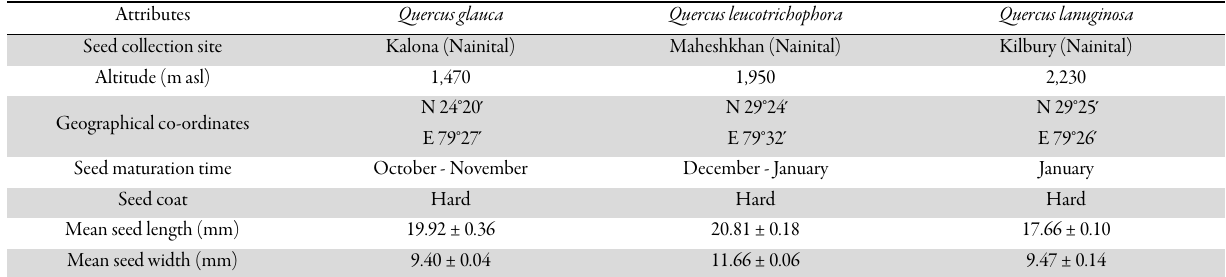
Table 2. Major seed characteristics of three oak species in Kumaun, West Himalaya